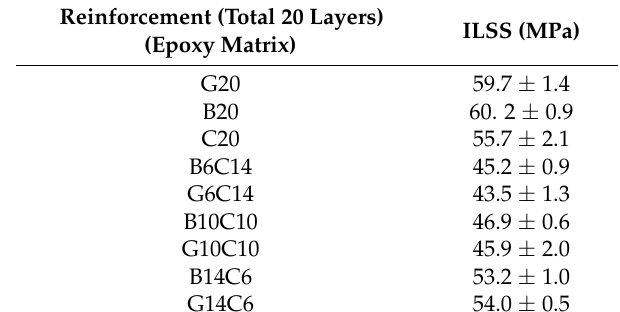
Table 4. The interlaminar shear strength of glass/basalt and carbon/basalt hybrid laminates with respect to the originating laminates [30] (from copy available at www.unitn.it).